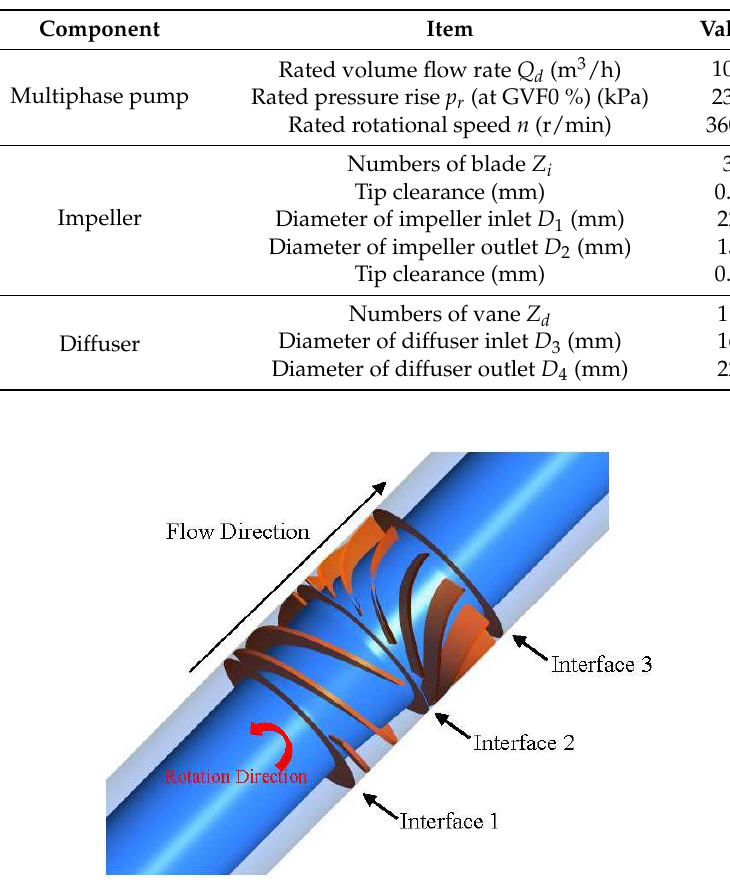
Table 1. Parameters of the model multiphase pump.